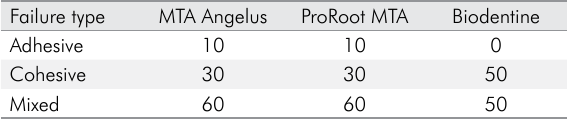
Table 2. Failure types (%) in each tested group after the push-out